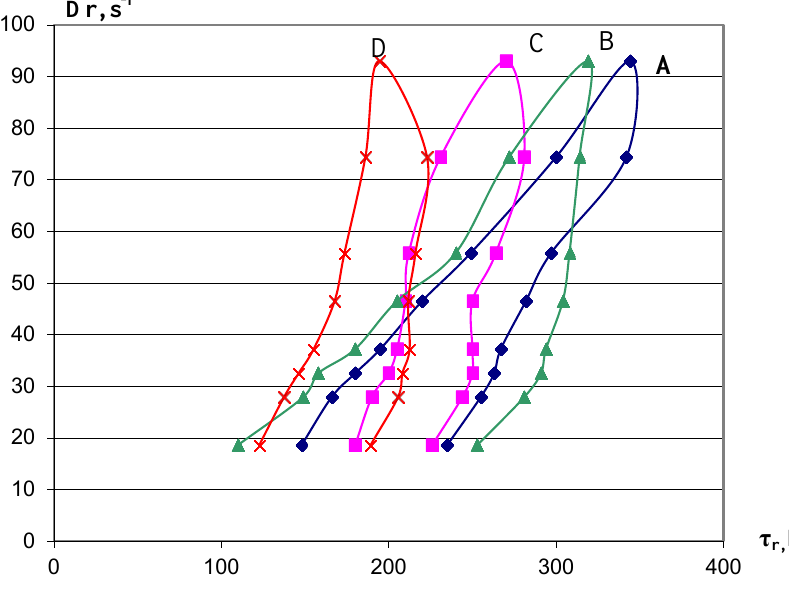
Fig. 1. Rheograms of gels: A – gel base; B – gel base +